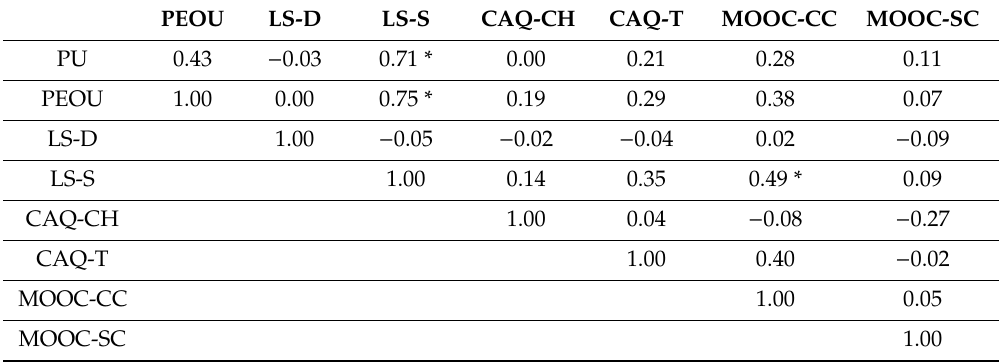
Table 2. Spearman correlation coe ffi cient (undergraduate students).